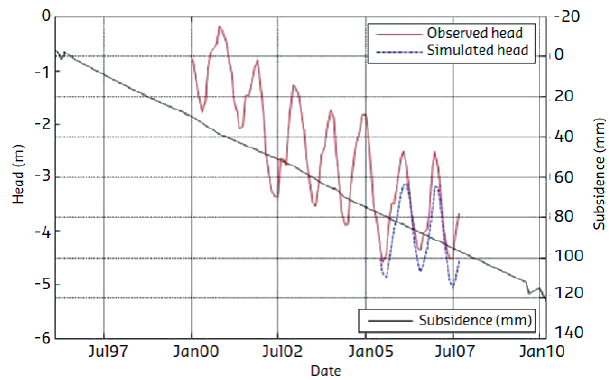
Figure 4. A distinct relation between falling hydraulic heads and subsidence in Ho Chi Minh City (Vietnam). This is indicative of an important contribution of groundwater over-exploration to sub- sidence, although it is not necessarily the only component contribut- ing to the total subsidence